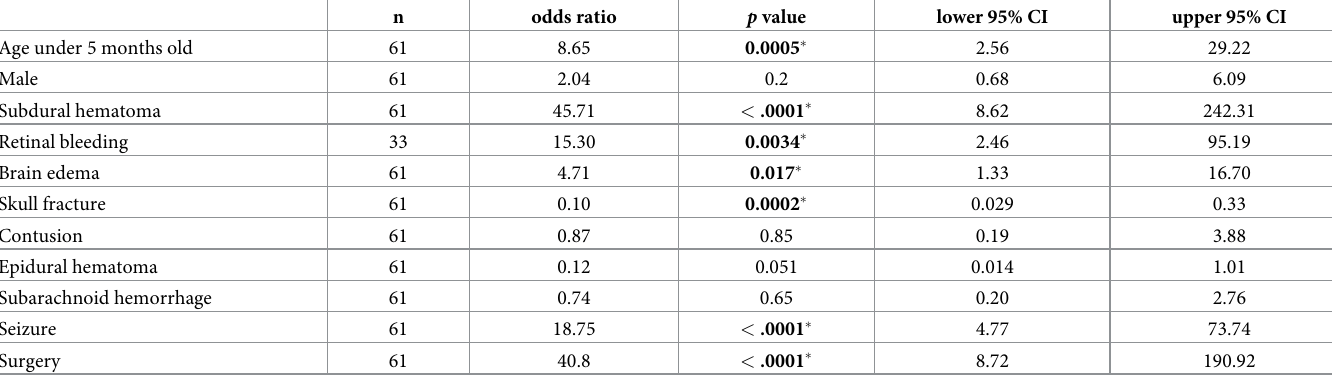
Table 5. Univariate analysis of confessed or accused abused cases vs traffic accidental cases.